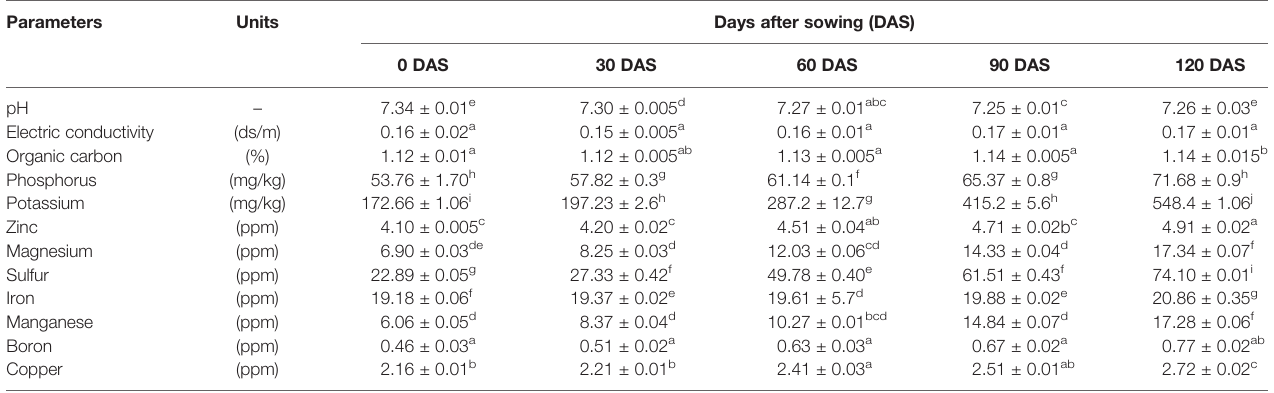
TABLE 2 | Soil nutrient analysis at different time intervals (0 DAS, 30 DAS, 60 DAS, 90 DAS, and 120 DAS). Parameters